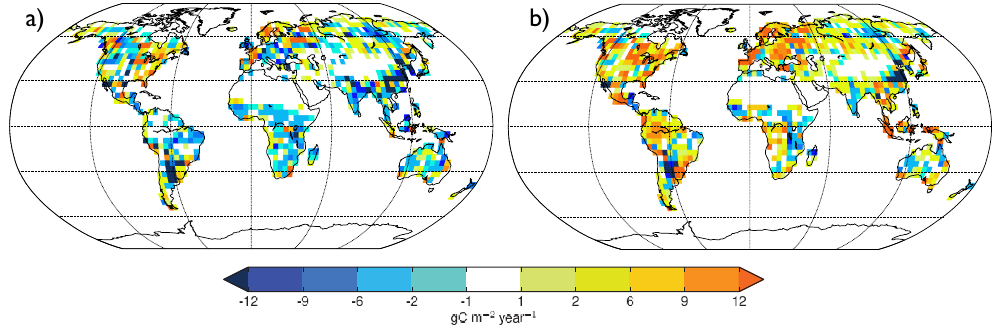
Fig. 5. Difference in the simulated atmosphere–land CO 2 flux averaged over the 1959–2005 period between the mosaic and composite approaches for (a) the Climate + CO 2 run and (b) the Climate + CO 2 + LUC run. Negative values indicate the atmosphere–land CO 2 flux is greater when using the composite approach; positive values indicate the atmosphere–land CO 2 flux is greater for the mosaic approach.